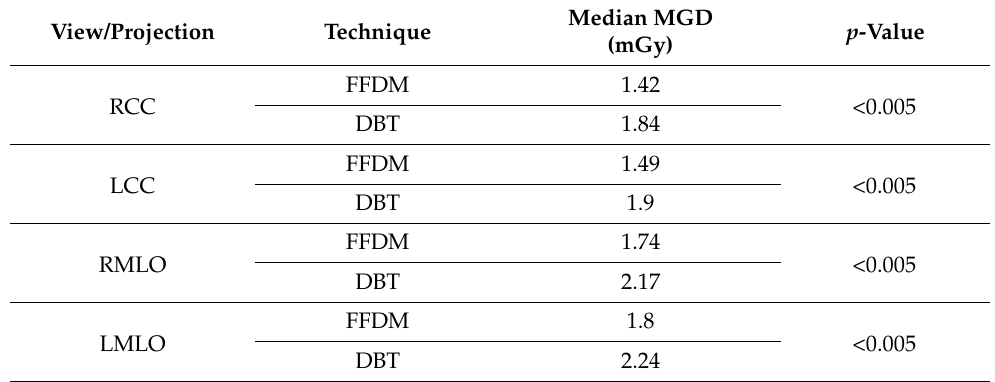
Table 3. MGD in FFDM and DBT.